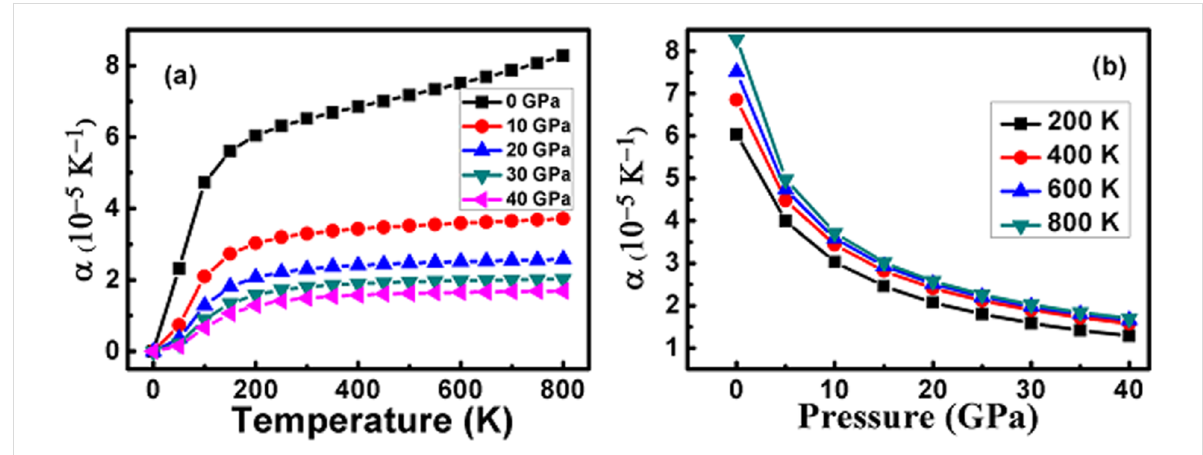
Figure 5: Variation of the thermal expansion coefficient as a function of (a) temperature and (b) pressure for the π -SnSe alloy.